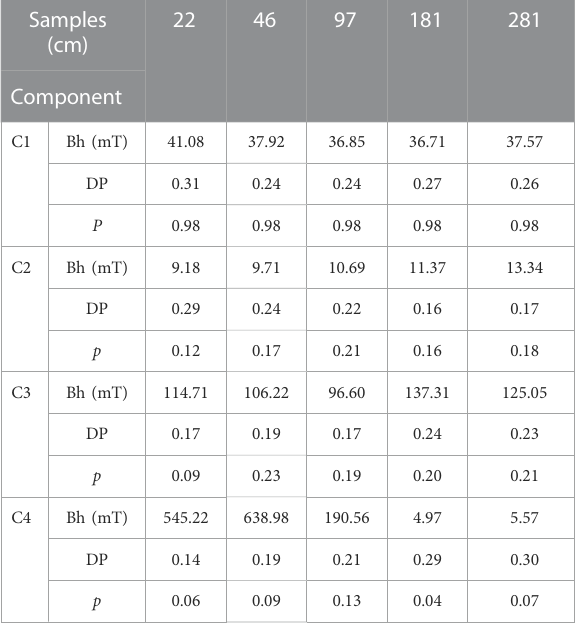
TABLE 2 IRM component unmixing of representative samples.